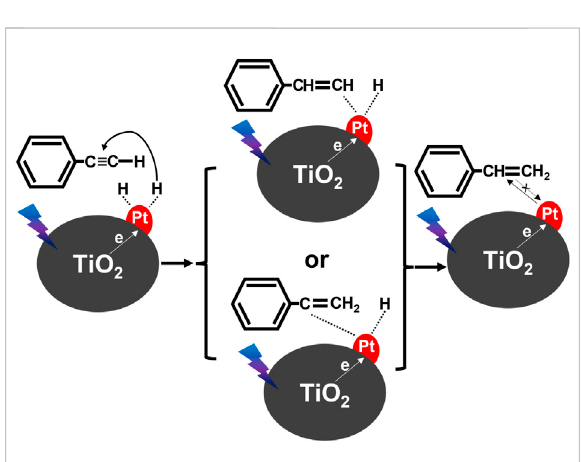
Proposed photocatalytic reaction mechanism for semi- hydrogenation of PLE over Pt/TiO 2 ; drawn based on the report by (Lian et al.,